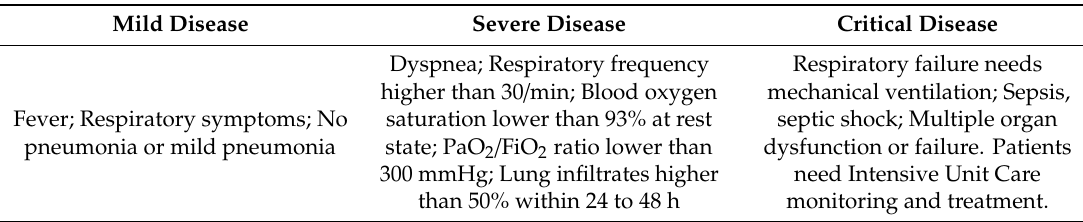
Table 1. Clinical manifestations of the COVID-19 pandemic classified by the severity according to the Chinese National Health